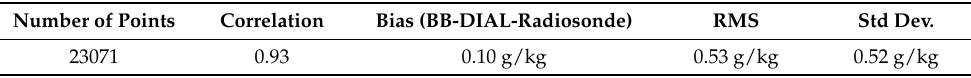
Figure 8. BB-DIAL bias, standard deviation and reported uncertainty versus radiosonde as a function of distance below the maximum reported height. The mean distance from the radiosonde location point and standard deviation is shown on the right-hand panel. Table 3. Statistical results corresponding with the scatter plot in Figure